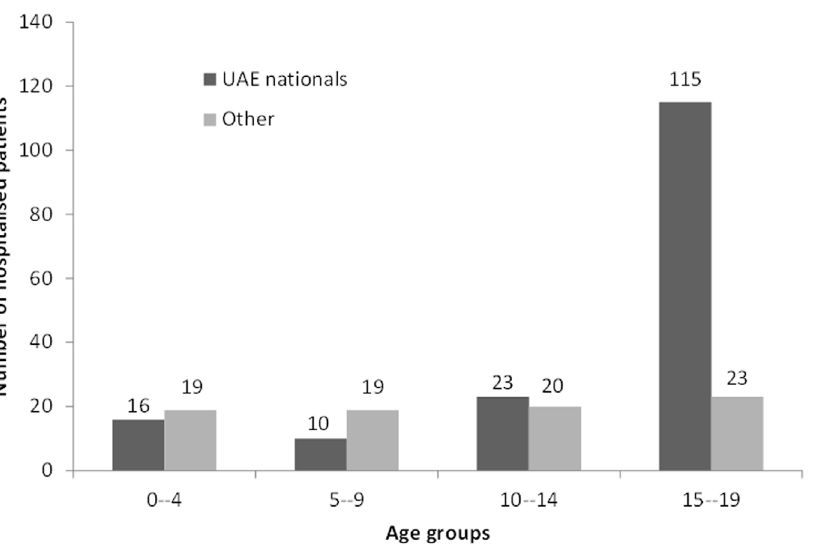
Figure 1. Traffic-related injury hospitalisations by nationality and age groups, Al Ain, 2006–2007 (n=245).